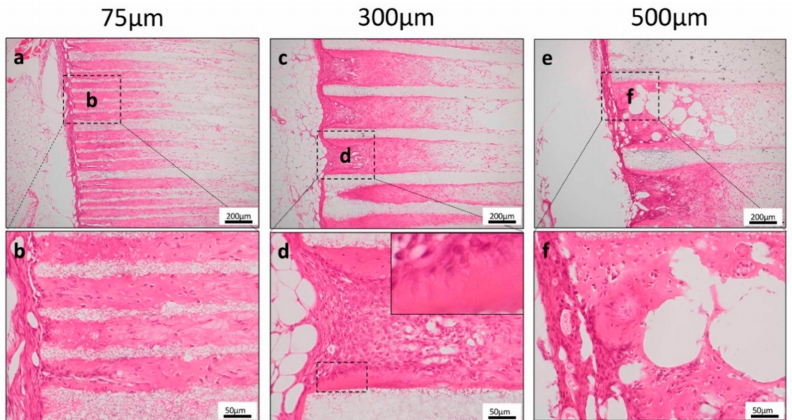
Figure 3. Histological findings in the ectopic experiment. ( a , b ) Bone-like hard tissue formation was observed near the entrance to the TCP holes for 75TCP. ( c , d ) Dentin-like structures around the